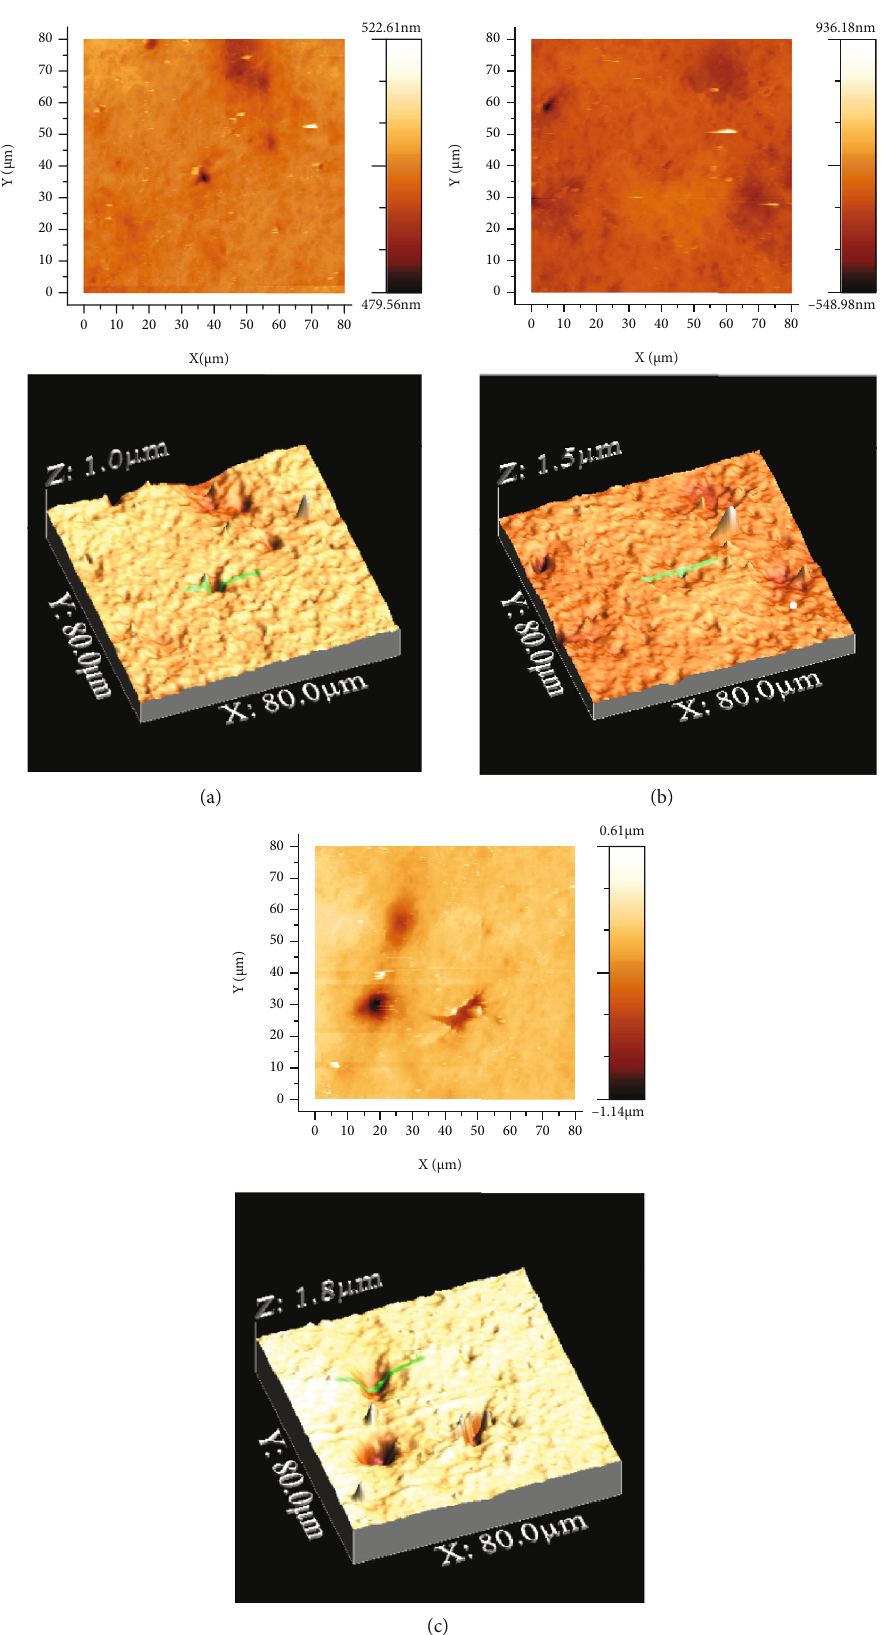
Figure 1: AFM topography images for the plasticized PHB and PHB biocomposites. (a) PHB/TBC, (b) PHB/BC1%, and (c)